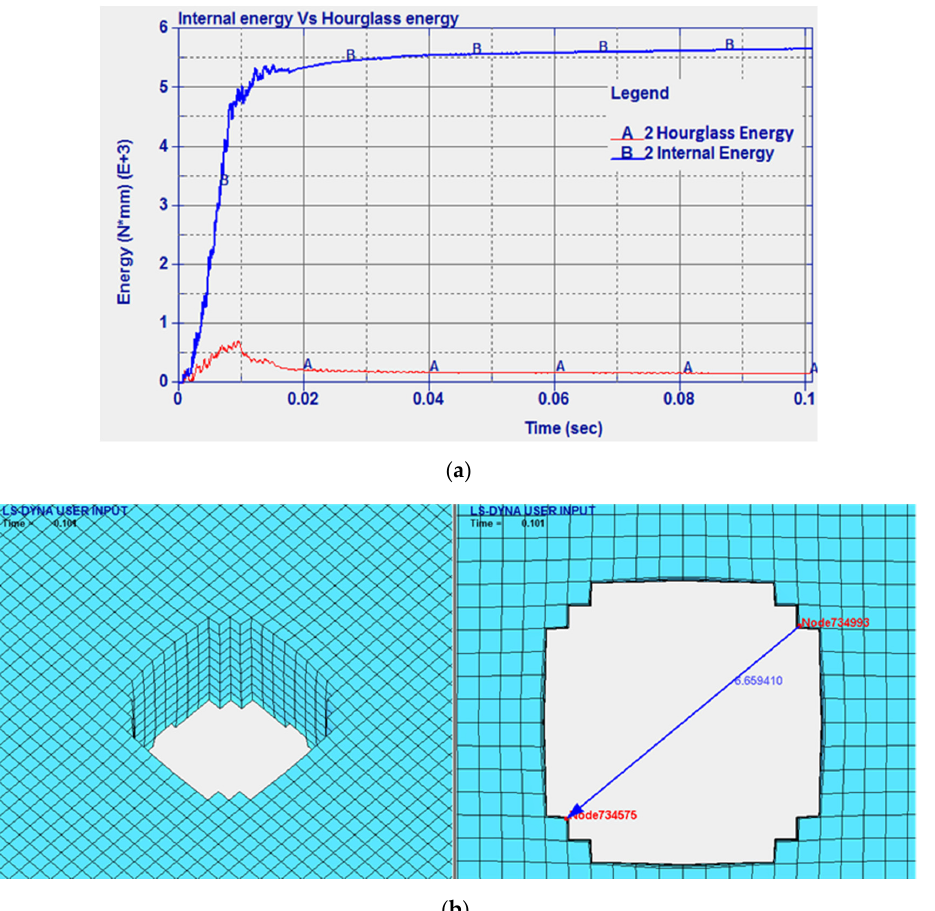
Figure 6. ( a ) Internal energy vs. hourglass energy, and ( b ) the 3D and 2D damage marks of the projectile penetrating the solid steel plate.